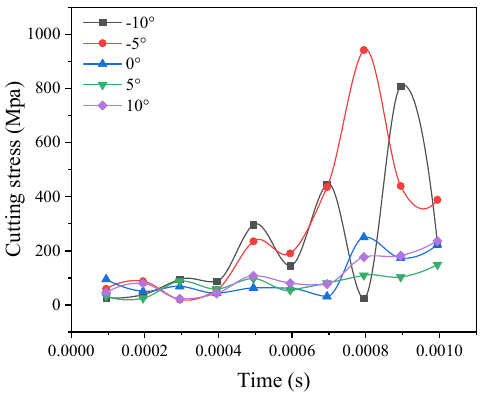
Figure 10. Comparison curve of the maximum stress of different tool rake angles.